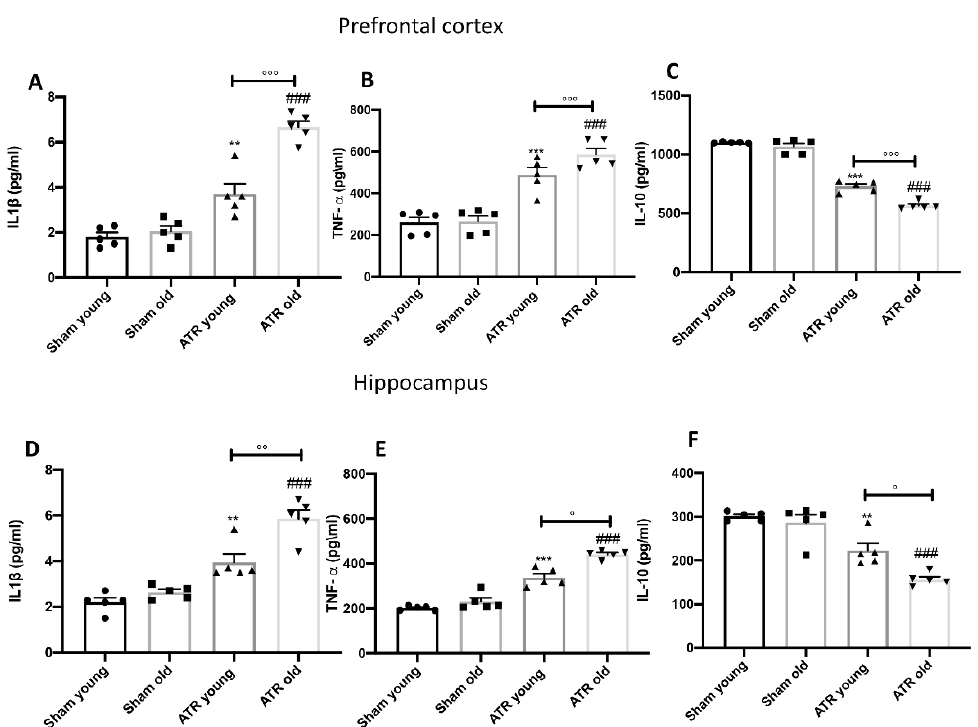
Figure 9. Impact of ATR inhalation on cytokines production. ELISA kit of IL-1 β ( A ) and TNF- α ( B ) and IL-10 ( C ) in prefrontal cortex. ELISA kit of IL-1 β ( D ) and TNF- α ( E ) and IL-10 ( F ) in hippocampus. After ATR exposure, both young and aged mice showed a significantly increase in pro-inflammatory cytokines production and a significantly decrease in IL-10 release in prefrontal cortex as well as in hippocampus. Statistical analysis reveal that older mice showed a major inflammatory response than younger mice. Data is expressed as the mean ± SEM of n = 5 animals for each group. ** p < 0.01 vs. Sham young; *** p < 0.001 vs. Sham young; ### p < 0.001 vs. Sham old; ◦ p < 0.05 ATR old vs. ATR young. ◦◦ p < 0.01 ATR old vs. ATR young; ◦◦◦ p < 0.001 ATR old vs. ATR young.